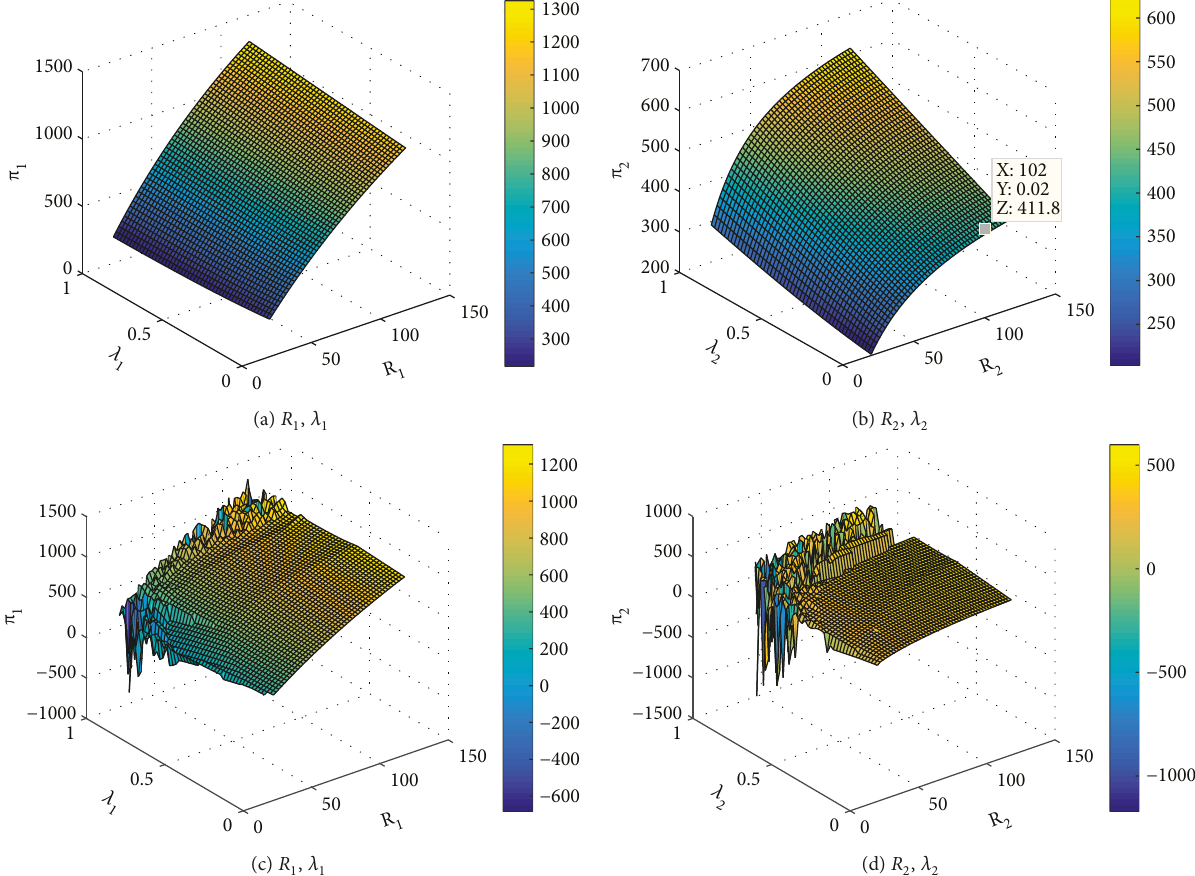
λ i and i on utilities of the two